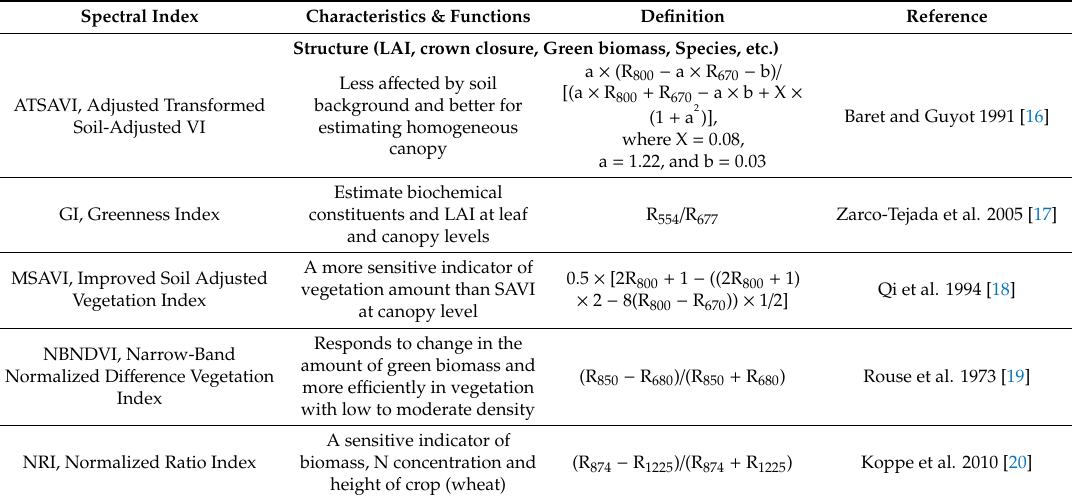
Table 4. Vegetation indices used in this